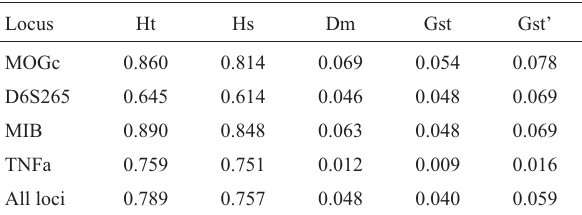
Table 5 - Gene diversity analysis.